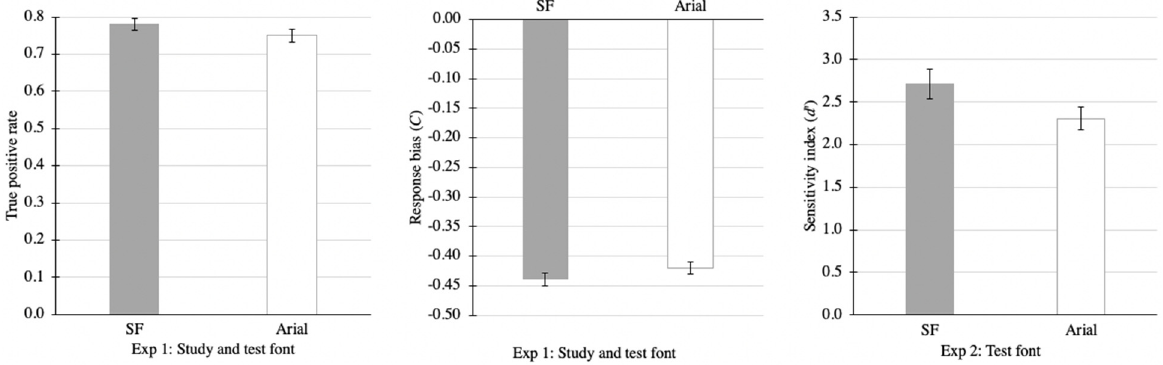
Figure 4. Summary of significant results from Experiment 1. Error bars represent standard error.